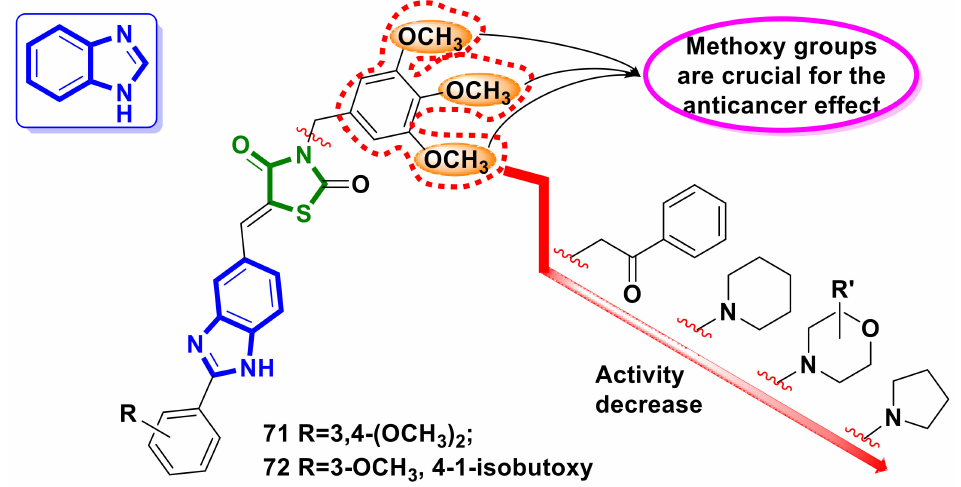
Figure 27. Benzimidazole–4-thiazolidinone hybrid molecules as potential anticancer agents and key SAR